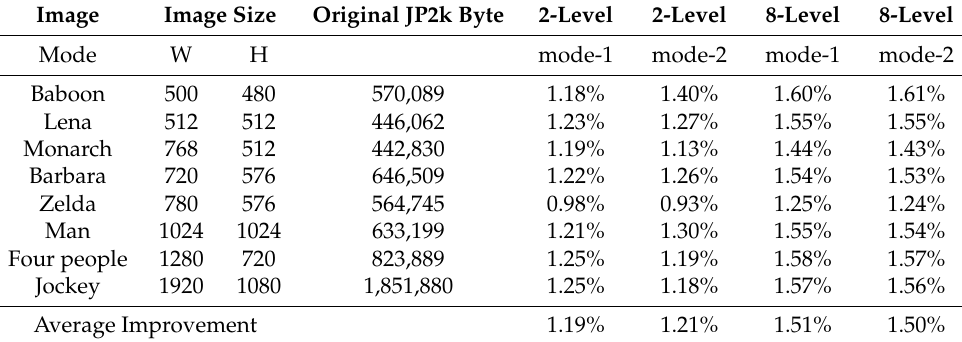
Table 17. Improvement percentage of compressed byte with proposed algorithm applying multi-level